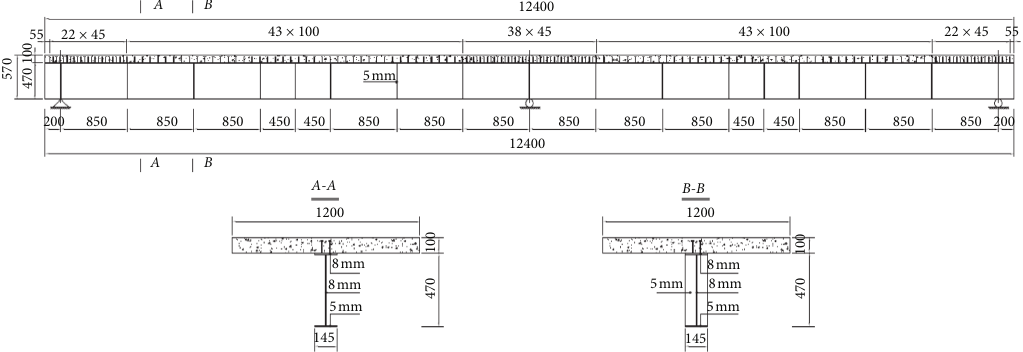
Figure 4: Beam geometry and dimensions (mm).